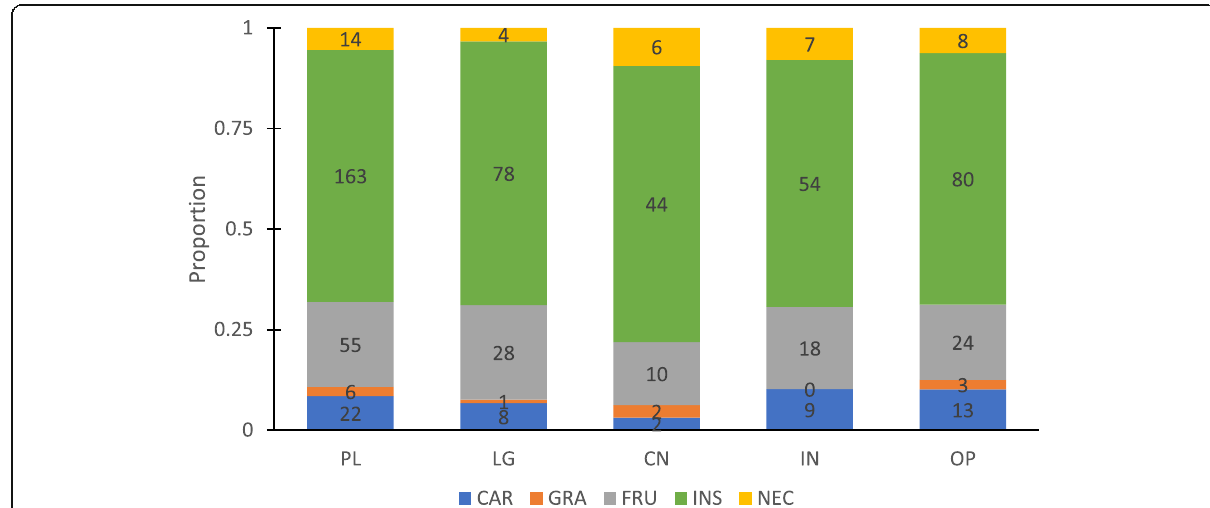
Fig. 4 Histogram plot of bird species according to their respective feeding guild throughout the study phases in Puah Lake Catchment, Hulu Terengganu, Peninsular Malaysia. y -axis indicates the proportion of each feeding guild ’ s species richness in its respective phase. The number on each bar represents the actual species richness of each feeding guild in each phase. Abbreviations: PL pre-log, LG logging, CN construction, IN inundation, OP operation, CAR carnivore, FRU frugivore, GRA granivore, INS insectivore, NEC nectarivore